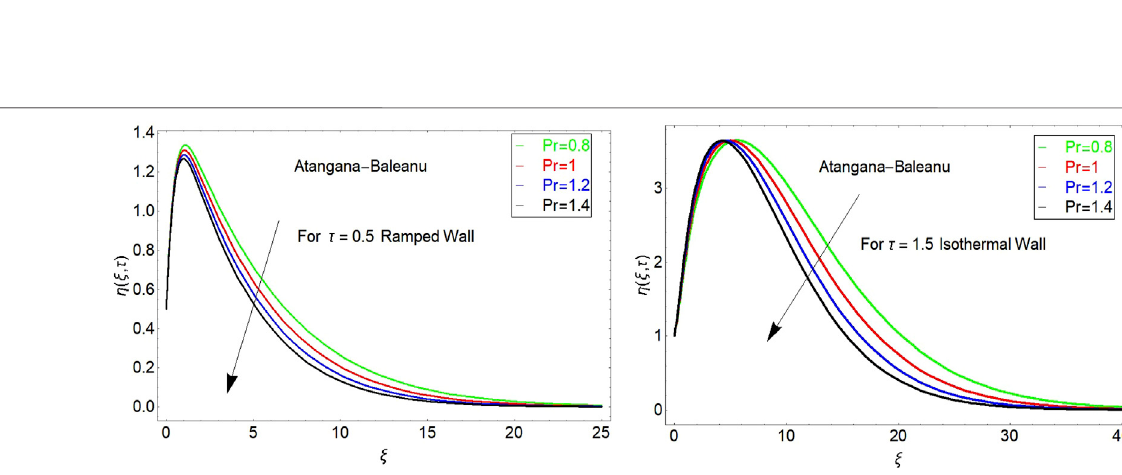
Frontiers in Physics |